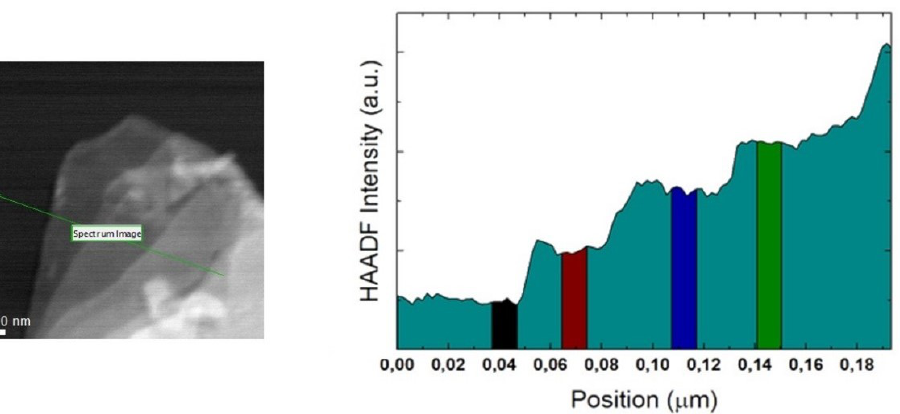
Figure 2. Characterisation of atomically thin Mo 0.5 W 0.5 S 2 flake. Left : HAADF-STEM micrograph. The location of the STEM-EELS spectrum line is marked using a green line. Right : HAADF-STEM intensity along the spectrum line. Region in black shows the spectra appertaining to aloof spec- troscopy. Highlighted flat windows show areas with the same number of layers, where spectra have been